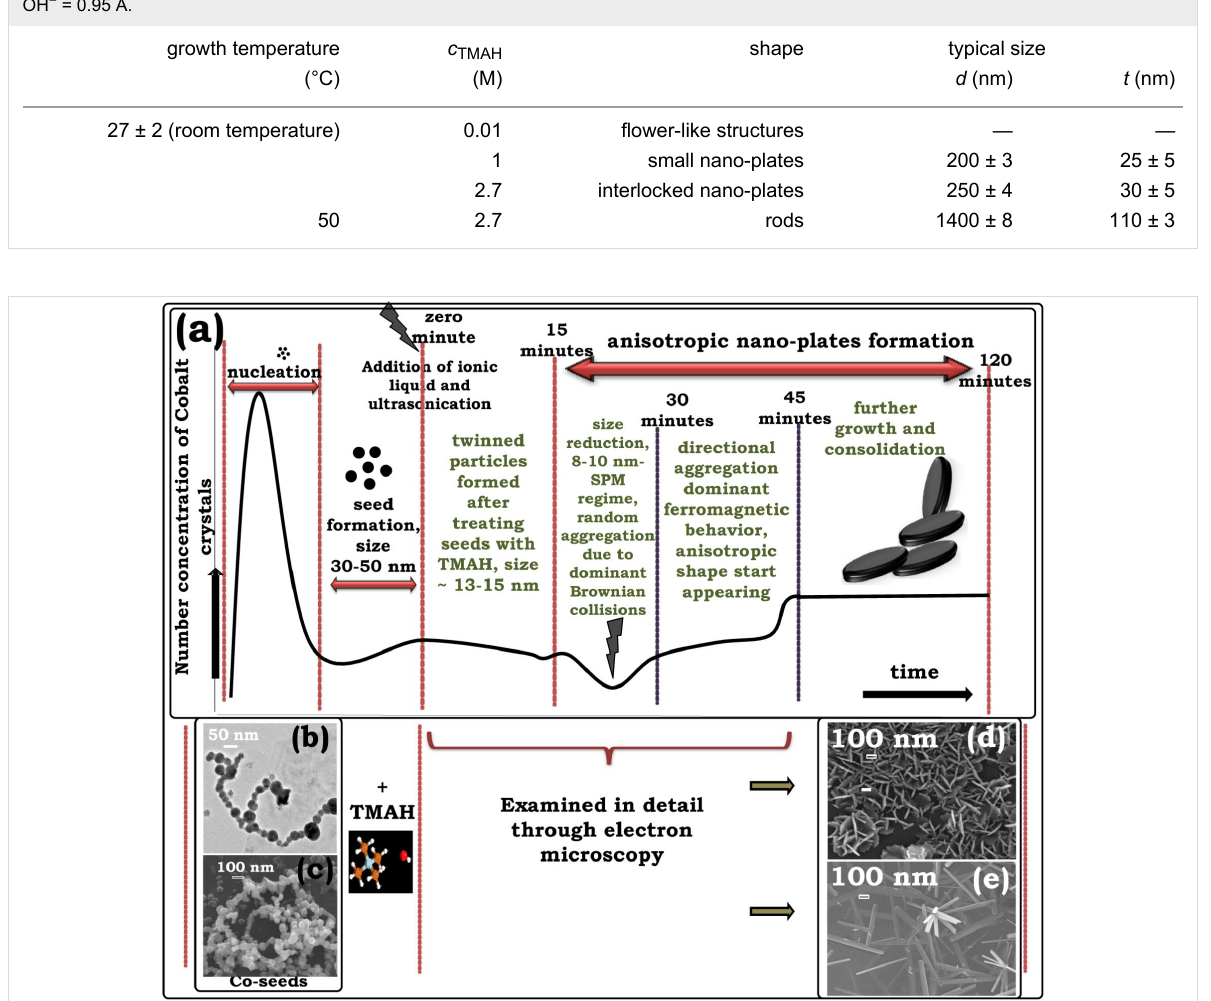
Figure 2: Schematic representation of growth and interlocking of cobalt nanoplates. (a) The growth curve shows that the formation of nanoplates can be divided into nucleation, kinetically driven seed formation, and growth; (b,c) FEGTEM and FEGSEM images of spherical cobalt seeds; (d) hierarchical long-range ordered crystalline nanoplates observed after 120 min, (e) nanorods obtained after 45